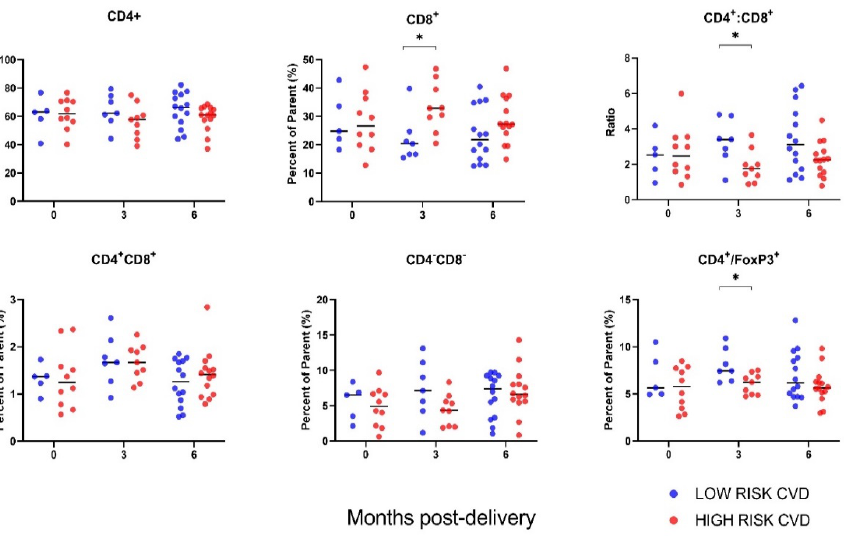
Figure 1. Maternal T-cell profiles by CVD risk. Immune cell data are stratified by participant lifetime CVD risk status at 6-months postpartum (low versus high). Results are reported as percent of the parent cell population (live/size/CD3 + CD45 + cells for all except for FoxP3 + T cells, for which the parent cell population is live live/size/CD3 + CD45 + /CD4 + T cells). Sample sizes at each time point: n = 15 at delivery, n = 16 at 3-months postpartum and n = 28 at 6-months postpartum. * p < 0.05 . Other non-T cell lymphocytes were examined. The proportion of circulating NK cells was significantly decreased at the time of delivery in high-risk CVD participants compared to low-risk CVD participants ( p = 0.0401), and not significantly elevated at 3-months postpartum ( p = 0.081) (Figure 2). There were no statistical differences between groups at 6-months postpartum ( p = 0.591). NK subsets were also examined, but no statistical differences between the study groups were observed across the time points.